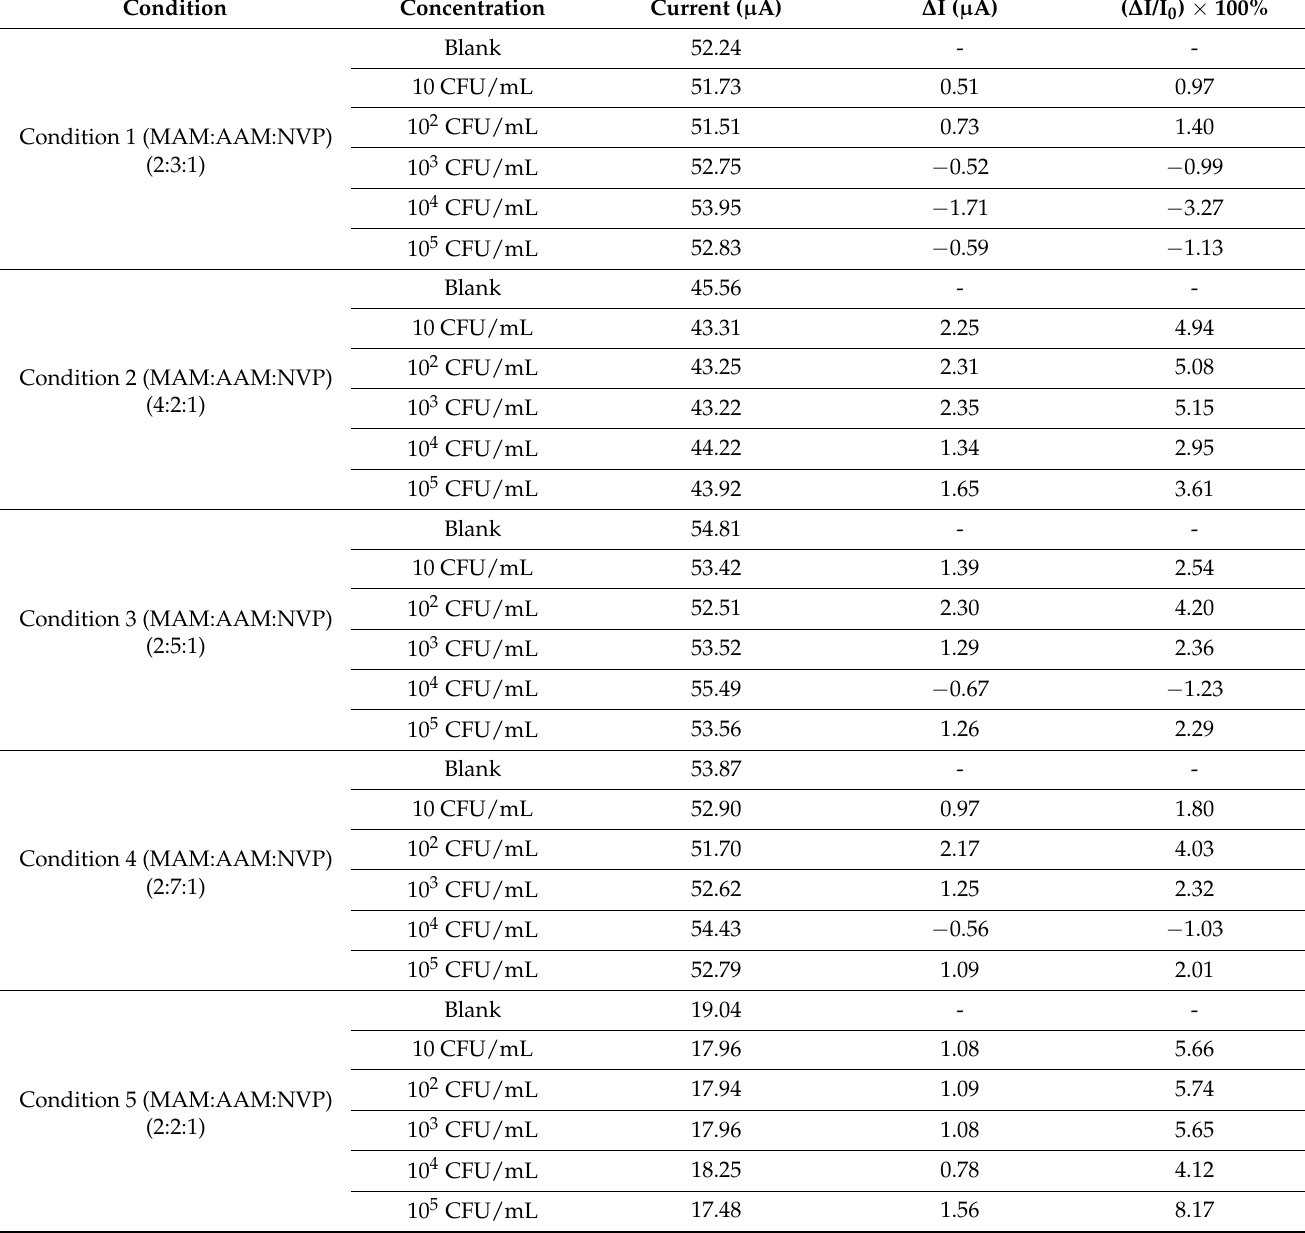
Table 3. The current data of conditions 1–10 on the carbon